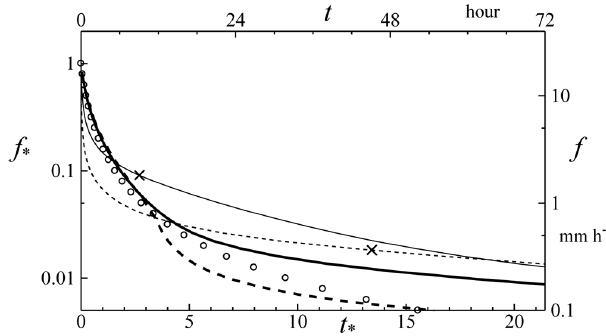
Fig. 7. Recession of the outflow rate from a sloping soil layer. Di- mensionless scales are used for the bottom and left axes, and dimen- sional scales converted by f m = 20mmh − 1 are used for the top and right axes. Thin solid line: λ = 29.7 and ε = 1. Thin broken line: λ = 148.7 and ε = 1. Thick solid line: λ = 29.7 and ε = 100. Thick broken line: λ = 148.7 and ε = 100. × : the outflow rate in which the saturation-excess overland flow is generated at the downslope end of the domain. (cid:13) : calculated by the storage and outflow-rate relationship optimised for catchment KT, as also shown in Fig.